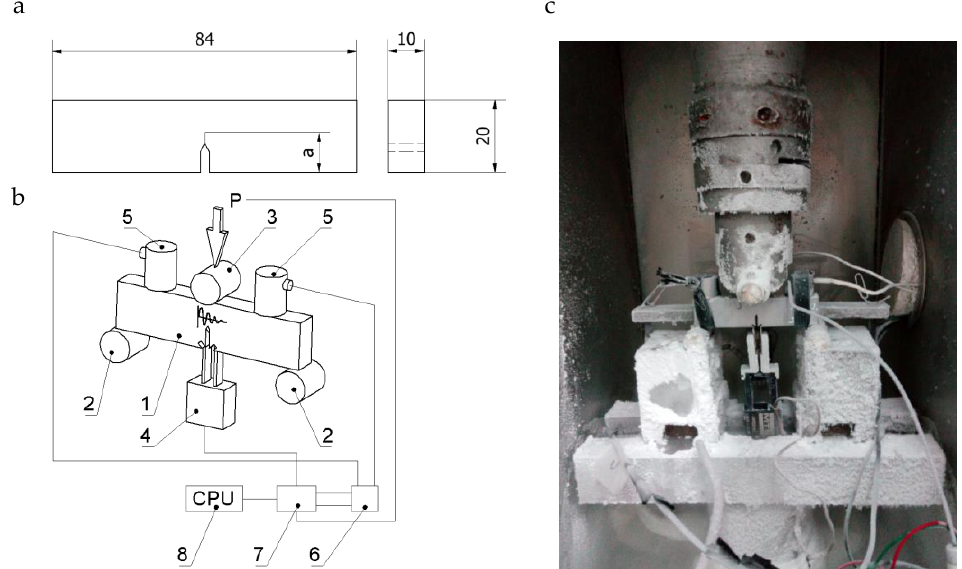
Figure 2. Schematic of an Single Edge Notched Bend (SENB) specimen ( a ). Schematic ( b ) and view ( c ) of the acoustic emission (AE) sensors placed during of the SENB specimen loading: 1—SENB specimen, 2—support rolls, 3—loading roll, 4—COD extensometer, 5 and 6—AE sensors, 7—transducer, 8—conditioner, and 9—PC.